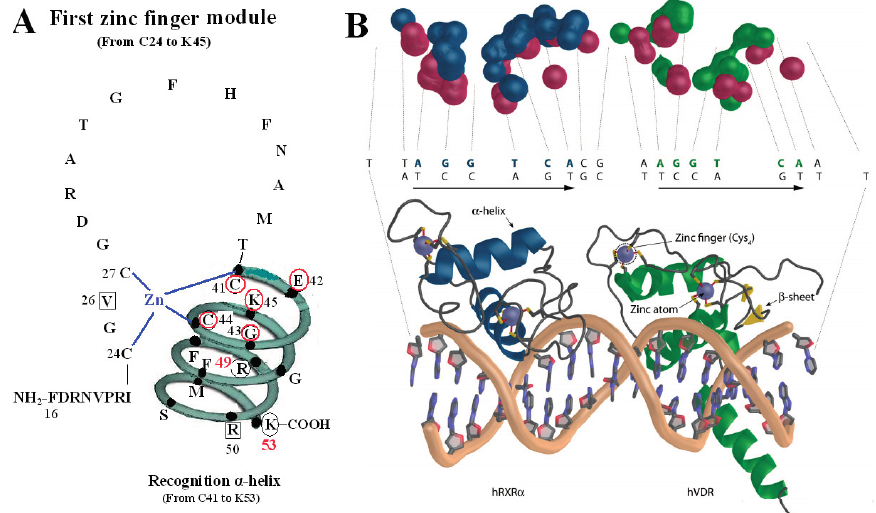
Figure 2. VDR DBD binds to VDR response elements (VDRE). ( A ) Amino acids of V26, P-box (from C41 to K45), R50 and S-box (R49 and K53) participate in binding to VDRE. ( B ) Pattern chart of the DBD complex of RXR-VDR on canonical DR3 element. (1) Bottom: The two zinc atoms are shown on spheres in light blue, RXR in blue and VDR in green. The α -helices are in gray and β -sheets in yellow. (2) Top: The contact atoms interacting between heterodimer and DNA are shown. DNA is shown in red, RXR in blue and VDR in green. Figure 2B adapted from Ferdinand Molnár and as originally published in Frontiers Media S.A. (2014)